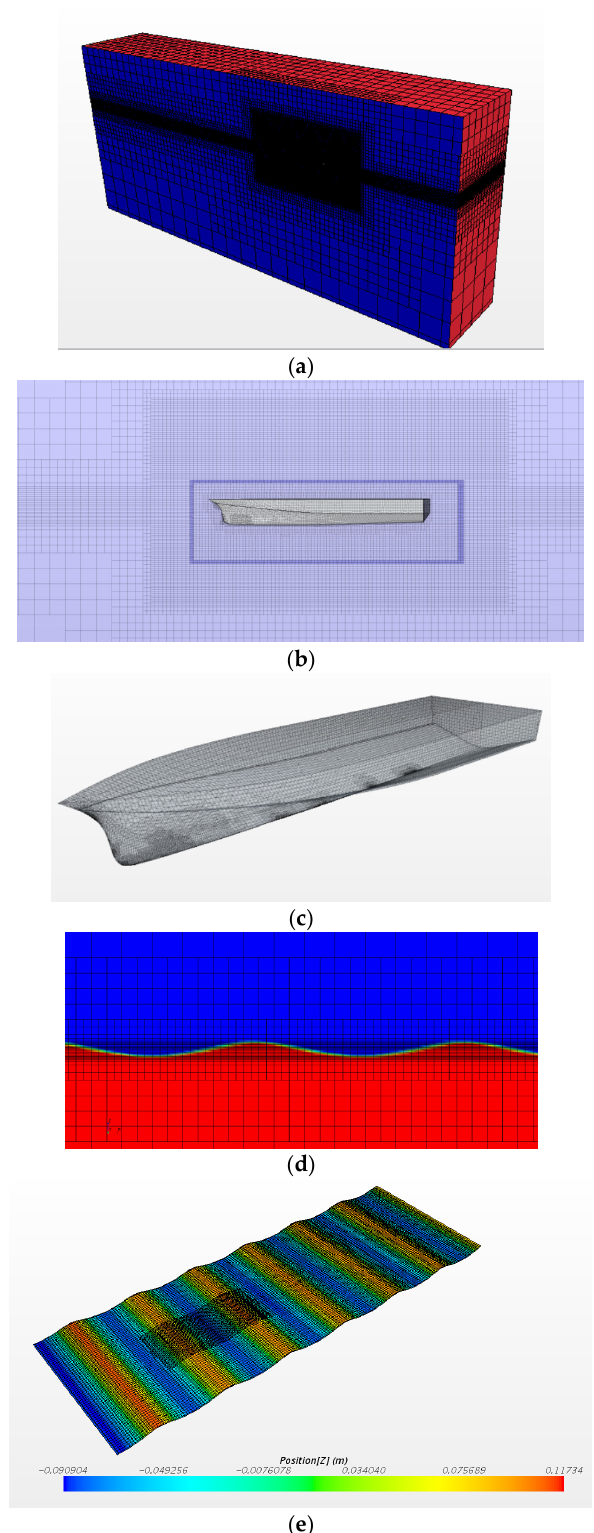
Figure 13. Calculation grids: ( a ) Domain grids; ( b ) Medium ‐ profile local grids; ( c ) Surface grid on the hull; ( d ) Grid near free surface; ( e ) Free surface of regular wave.